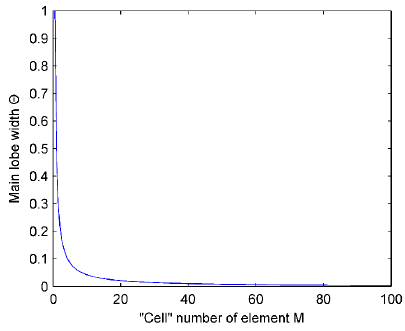
Figure 7. Influence of the “cell” number of element M on the width of main lobe Θ .